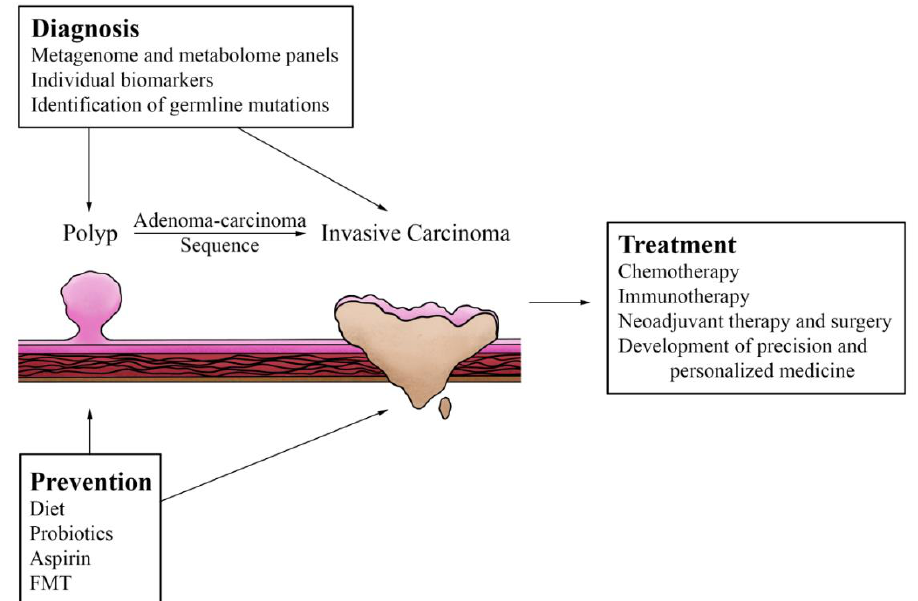
Figure 2. Preventative, diagnostic, and therapeutic options that influence and are under the influence of the microbiome. Interventions such as chemotherapy and aspirin prophylaxis have been shown to influence or be influenced by certain aspects of the microbiome. Research continues to provide or suggest newer management strategies as well, such as use of immunotherapy in colorectal cancer, development of personalized biomarkers, and consideration of fecal microbiota transplant (FMT), all of which also have complex interactions with the gut